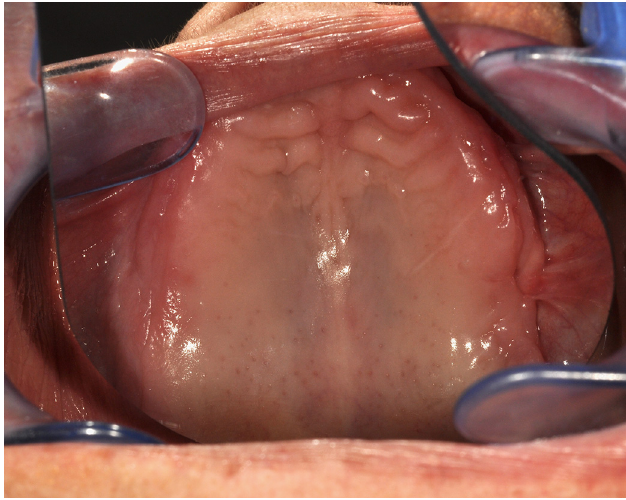
Fig. 4. Postoperative clinical photograph. Postoperative clinical photograph at 2 months showing no reopening of the oroantral fi stula.